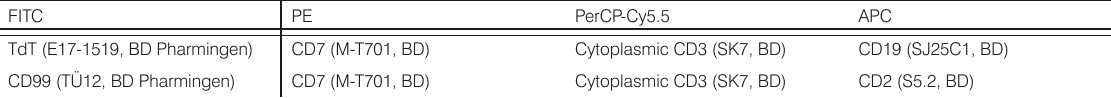
Figure 1. ”Live-gate” for an acquisition of cCD3 positive events: a region is set on a cCD3 positive cells with a low-to- intermediate side scatter, cells in this region are saved for subsequent analysis while totally acquiring up to 1 million cells.